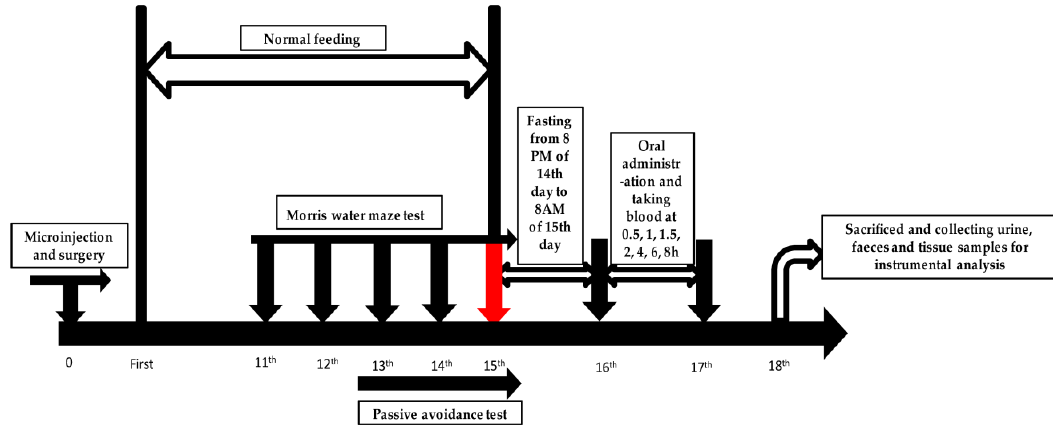
Figure 6. All experimental procedures and animal facilities were approved by the institutional Animal Care and Use Committee of the Center of Functional Inspection of Health Food, College of Applied Science and Humanities, Beijing Union University. The animal experiment, which was approved by above committee from December 2017 to June 2018 and numbered as 2017-59, had the same title as this paper. There were no significant differences in body weights and food intakes between the sham control group and the model group throughout the experiment.